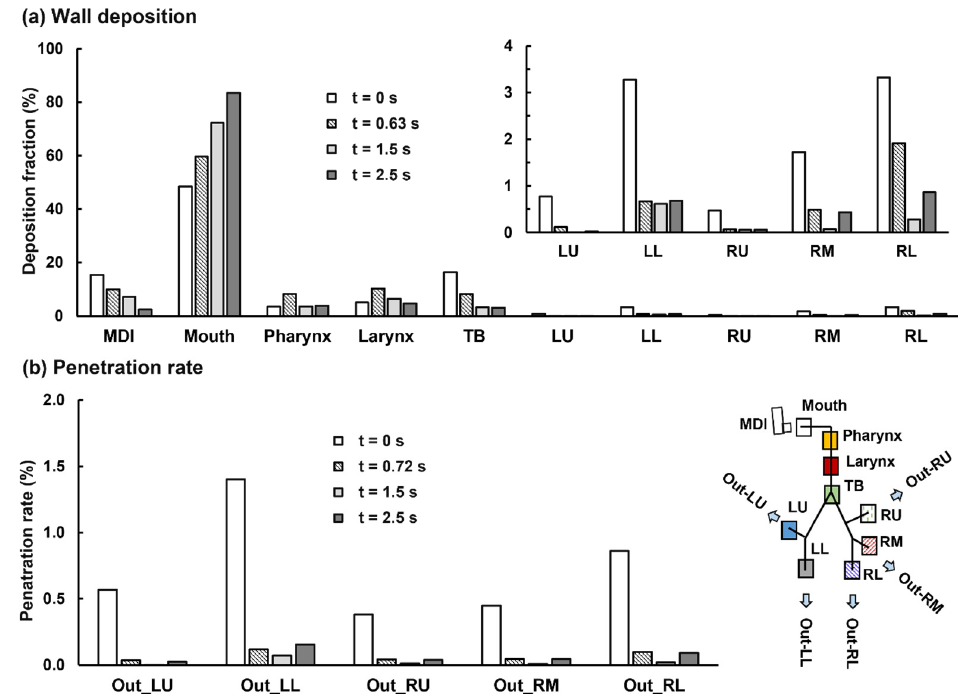
Figure 11. Comparison of the mass-based dosimetry between four delivery scenarios when the MDI was actuated at four different time-points of the inhalation waveform: ( a ) regional wall deposition and ( b ) lobar penetration rate.